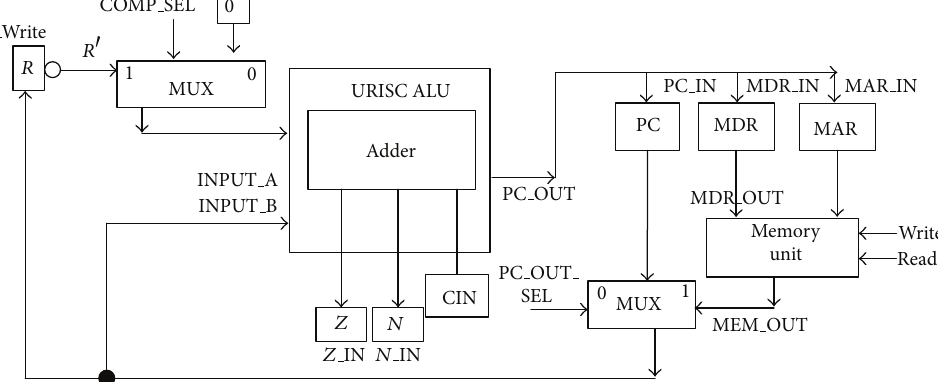
Figure 16: The URISC SBN architecture with Adder